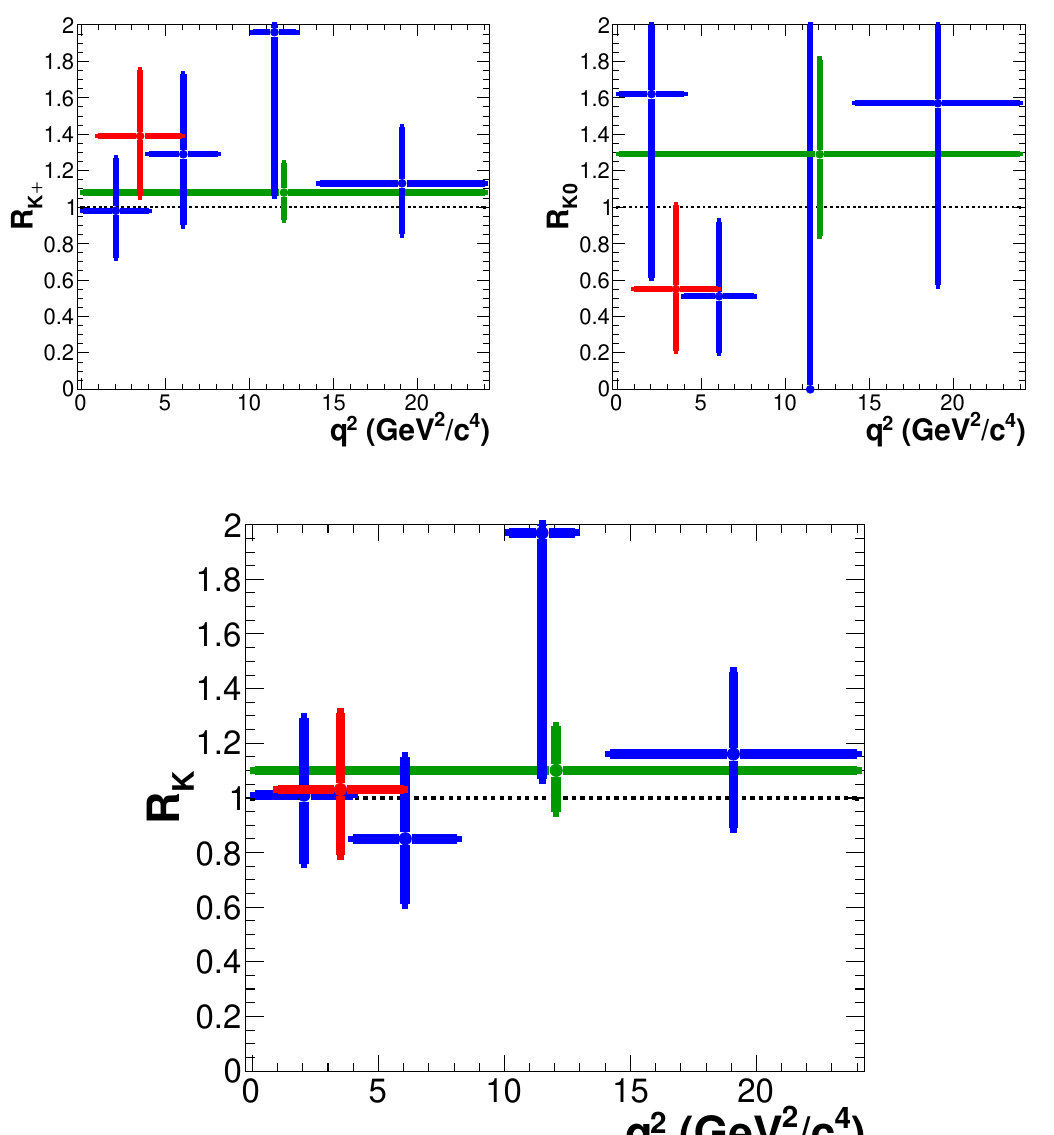
Figure 3 . R K in bins of q 2 , for B + → K + ‘ + ‘ − (top-left), B 0 → K 0 both modes combined (bottom). The red marker represents the bin of 1 . 0 < q 2 < 6 . 0 GeV 2 /c 4 , and the blue markers are for 0 . 1 < q 2 < 4 . 0 , 4 . 00 < q 2 < 8 . 12 , 10 . 2 < q 2 < 12 . 8 and q 2 > 14 . 18 GeV 2 /c 4 bins. The green marker denotes the whole q 2 region excluding the charmonium